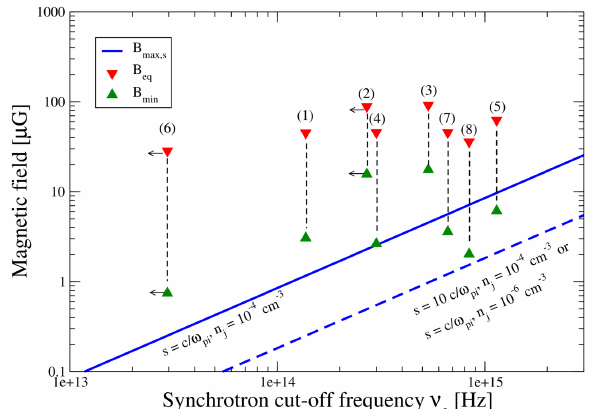
Figure 3. Upper limit B max , s for the magnetic field imposed by the condition s ≥ c /ω pi when t acc = t synchr . Triangles indicate the maximum ( B eq , red triangles down) and minimum ( B min , green triangles up) field for the sources in [20]; see Table